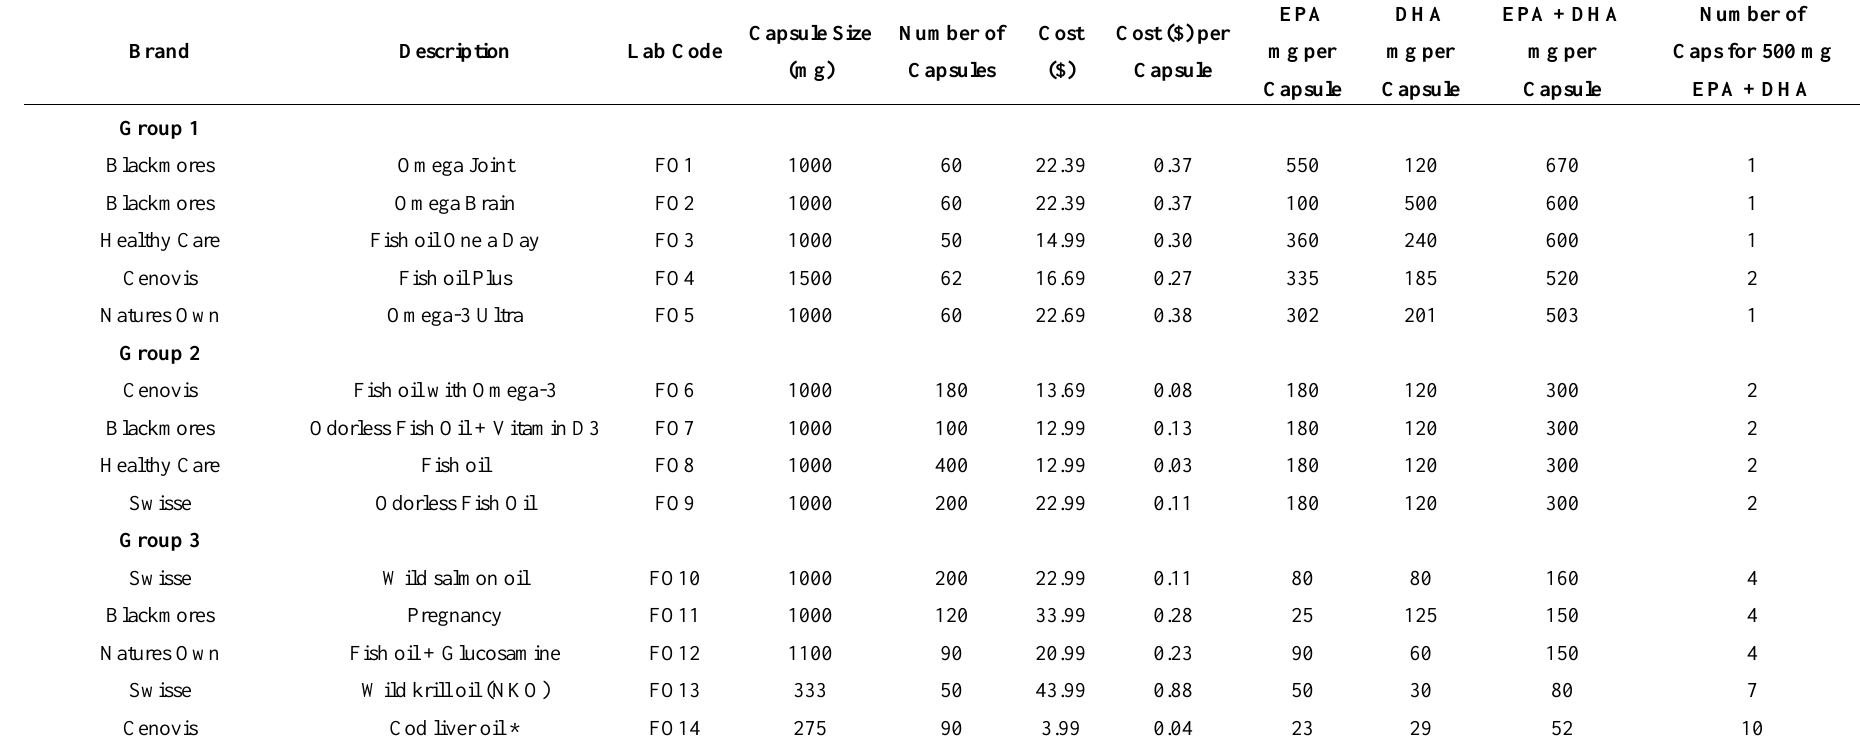
Table 3. Fish oil capsules—brand and composition details as supplied by